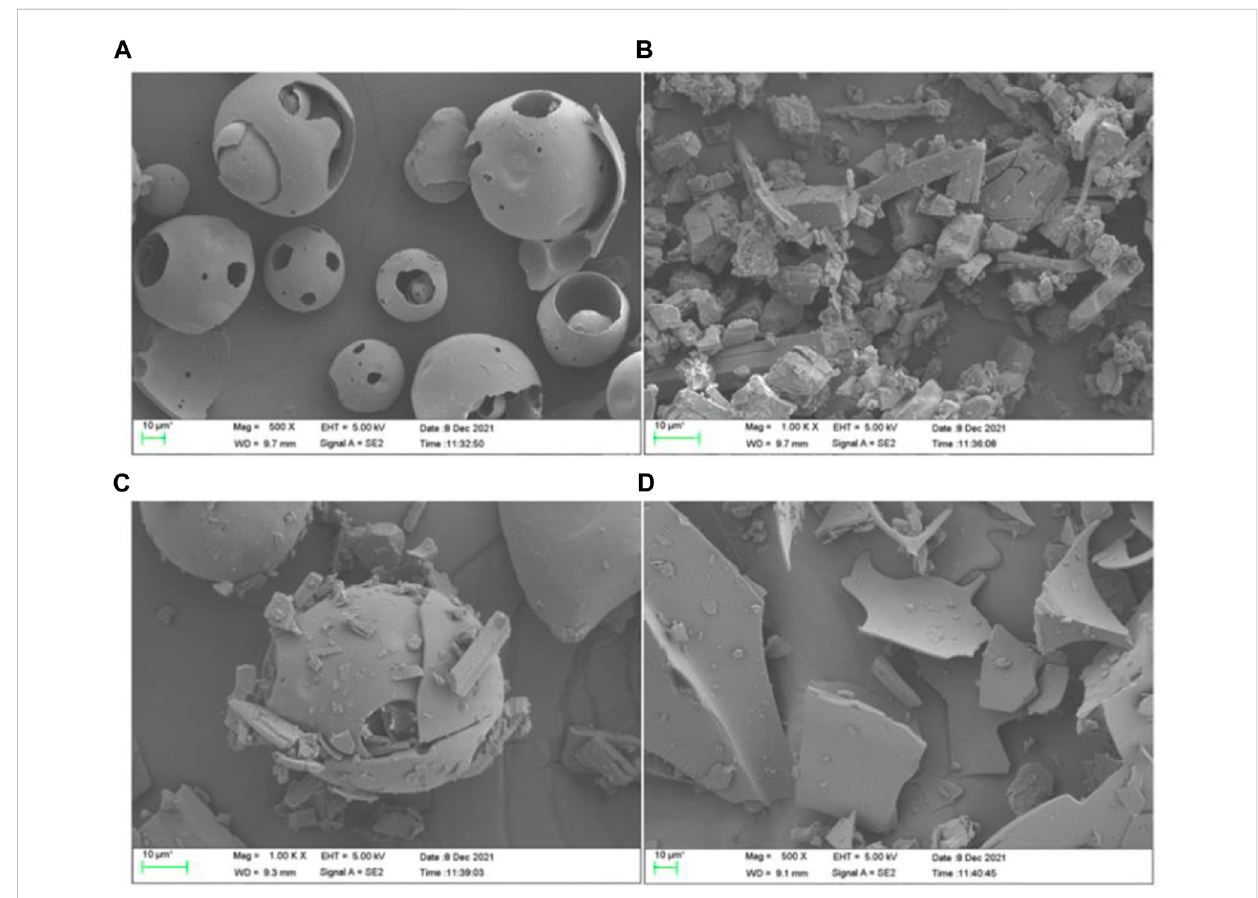
The scanning electron microscope images of HP- γ -cyclodextrin (A) , icariin (B) , the physical mixture of icariin and HP- γ -cyclodextrin (C) , and their inclusion complex (D) .